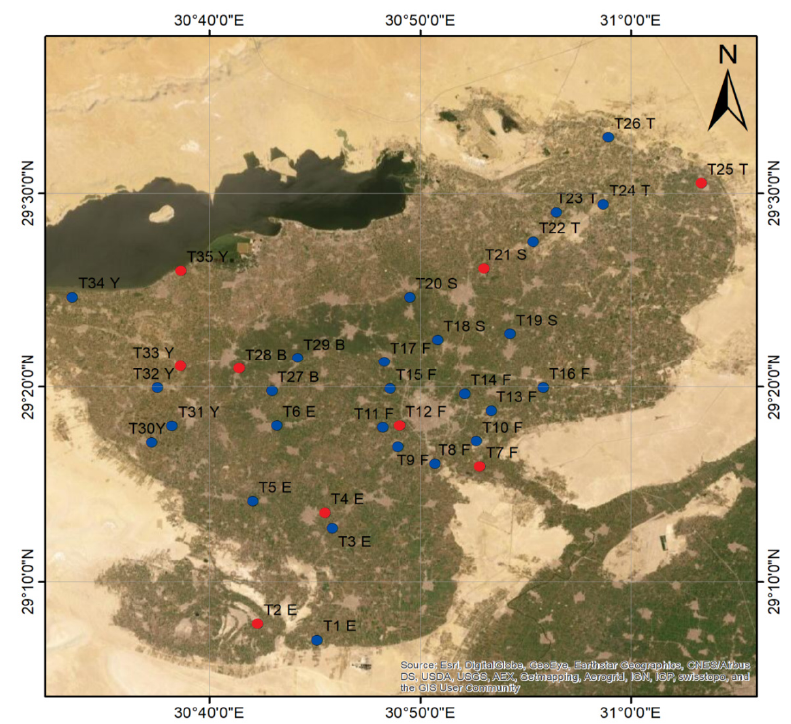
Figure 8. Geographical distribution map of 35 T. portulacastrum samples collected from the Fayoum Depression, Egypt. The red dots indicate the nine samples selected for leaf and seed micromorpho- logical (SEM) studies, based on the cluster analysis of macromorphological characteristics.